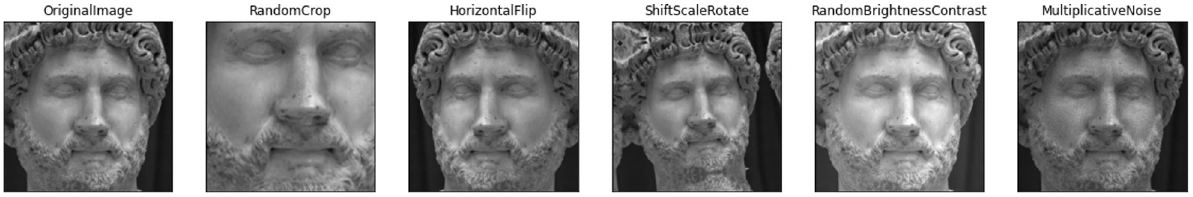
Fig. 5 Augmentations applied to images (Buslaev et al. (2020)). Image of Hadrian: © Centre for Art Historical Documentation, Radboud University.